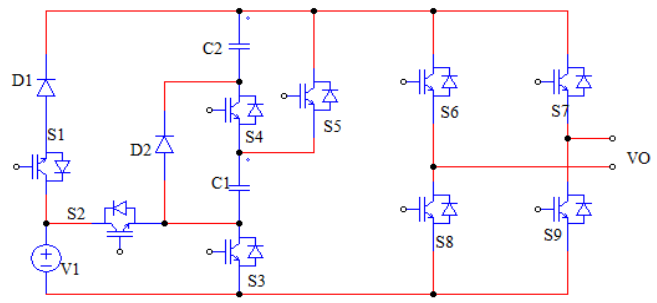
Figure 3. Nine-switch, nine-level topology [52].